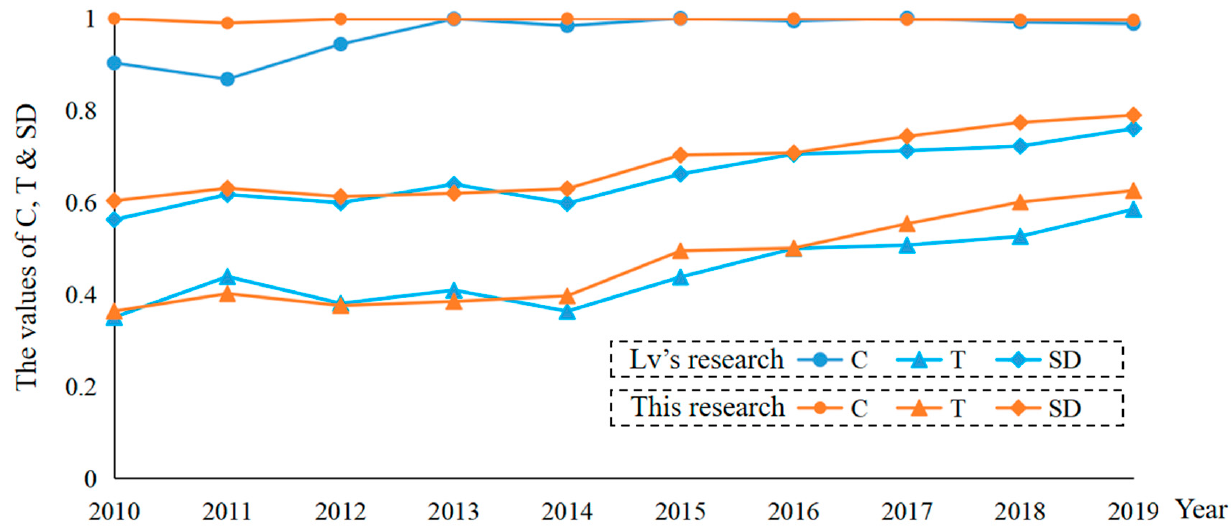
Figure 10. Evaluation results of this research and Lv’s method.